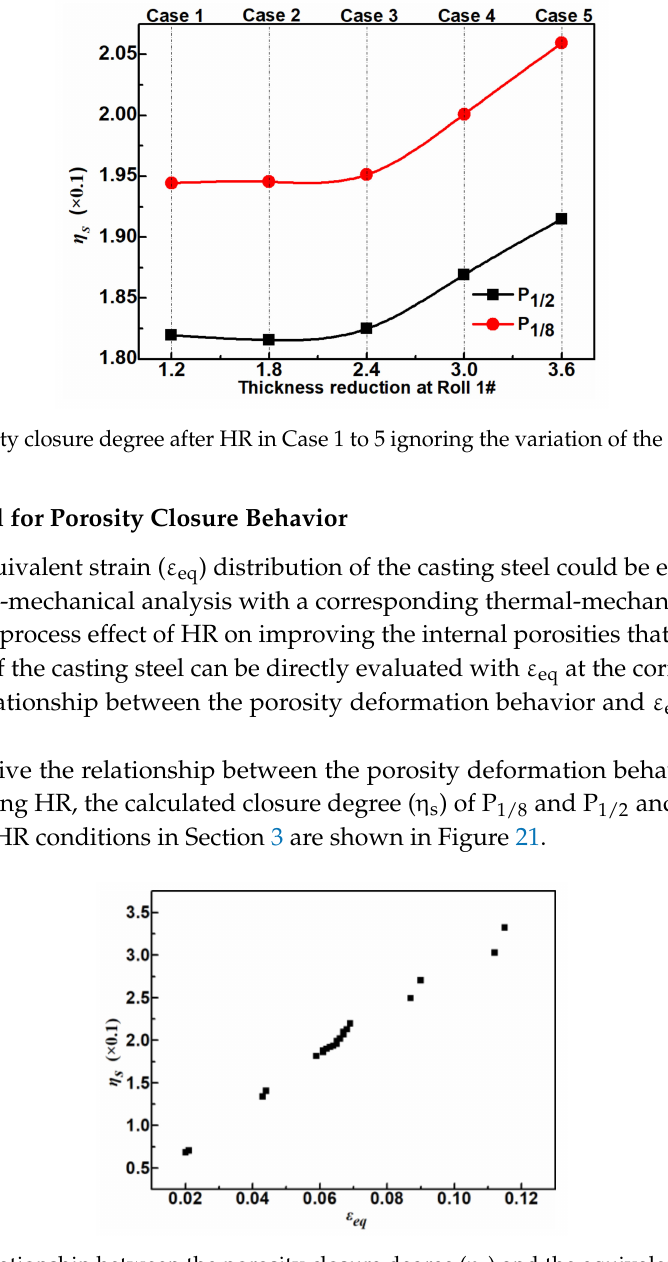
Figure 21. Relationship between the porosity closure degree ( η s ) and the equivalent strain ( ε eq